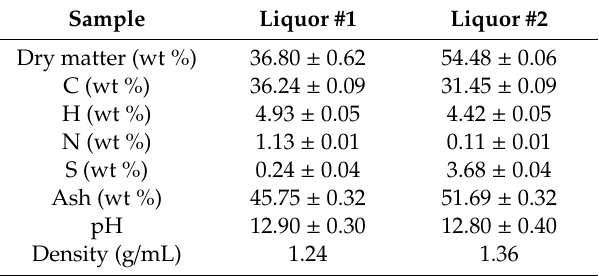
Table 2. Chemical characterization of black liquors (% of oven-dry weight). Data represent means ± standard